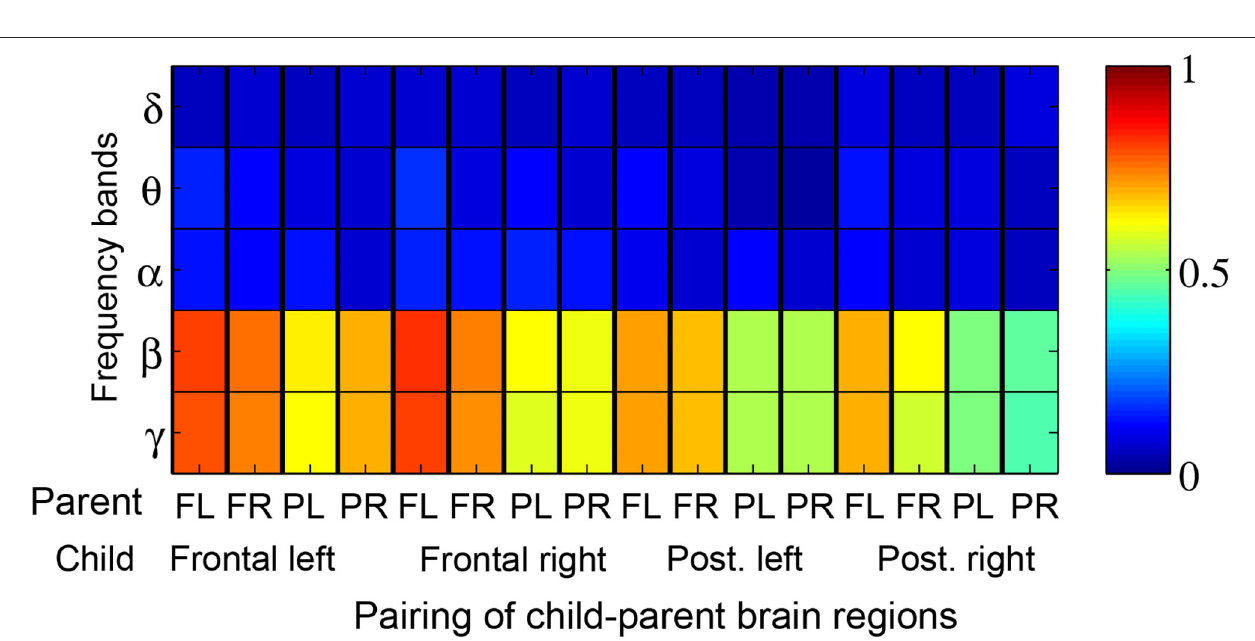
FIGURE 6 | Proportion of child-parent dyads exhibiting significant increases in coherence over the course of a music therapy session. Red shading thus denotes 100% of dyads with significant increases in coherence. The proportions are tabulated by frequency band (rows) and pairing of child-parent brain regions i.e., frontal left (FL), frontal right (FR), posterior left (PL), and posterior right (PR).